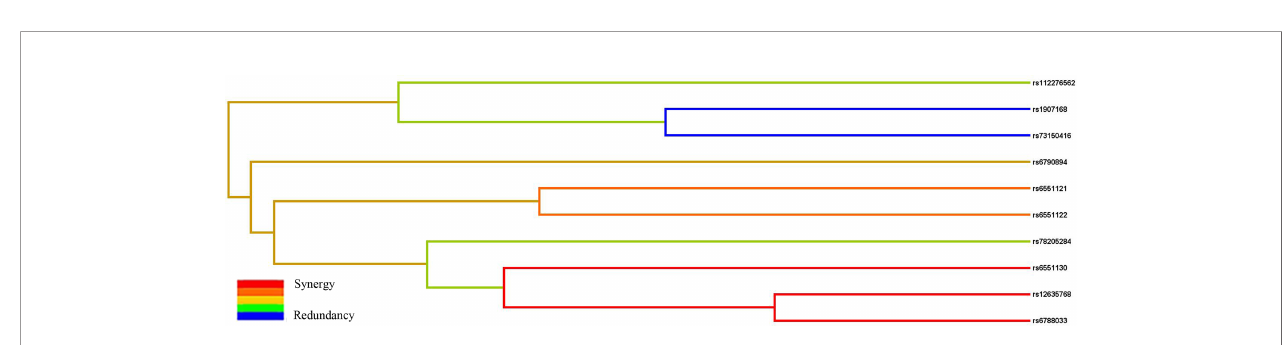
FIGURE 2 | The interaction dendrogram derived from MDR for the SNP – SNP interaction in LRRC3B . Short connections among nodes represent stronger synergistic (red and orange) or redundant (green and blue) interactions.